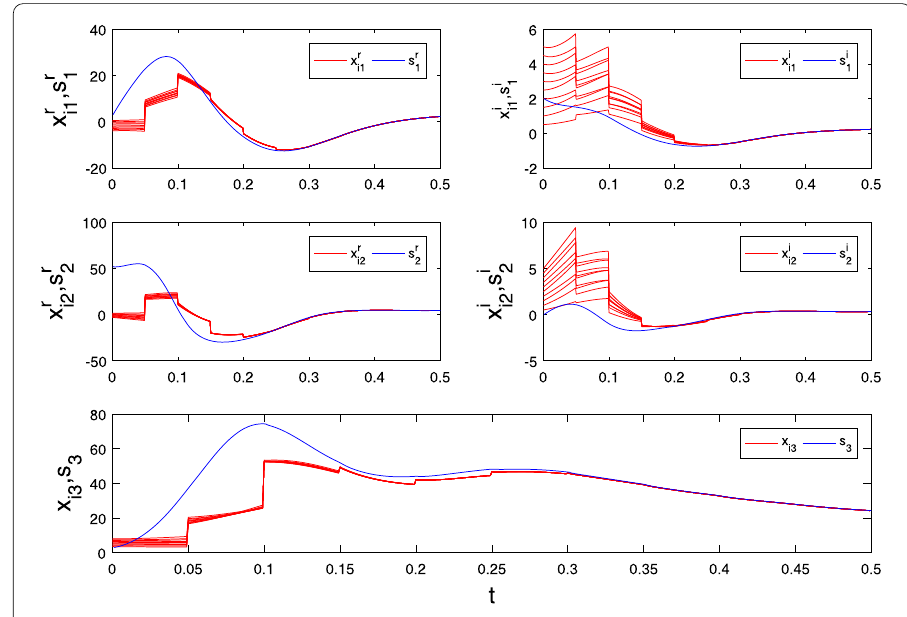
with ε = 0.001. Figure 3 shows the orbits of the real and imaginary parts of x kl ( t ) and s l ( t ),